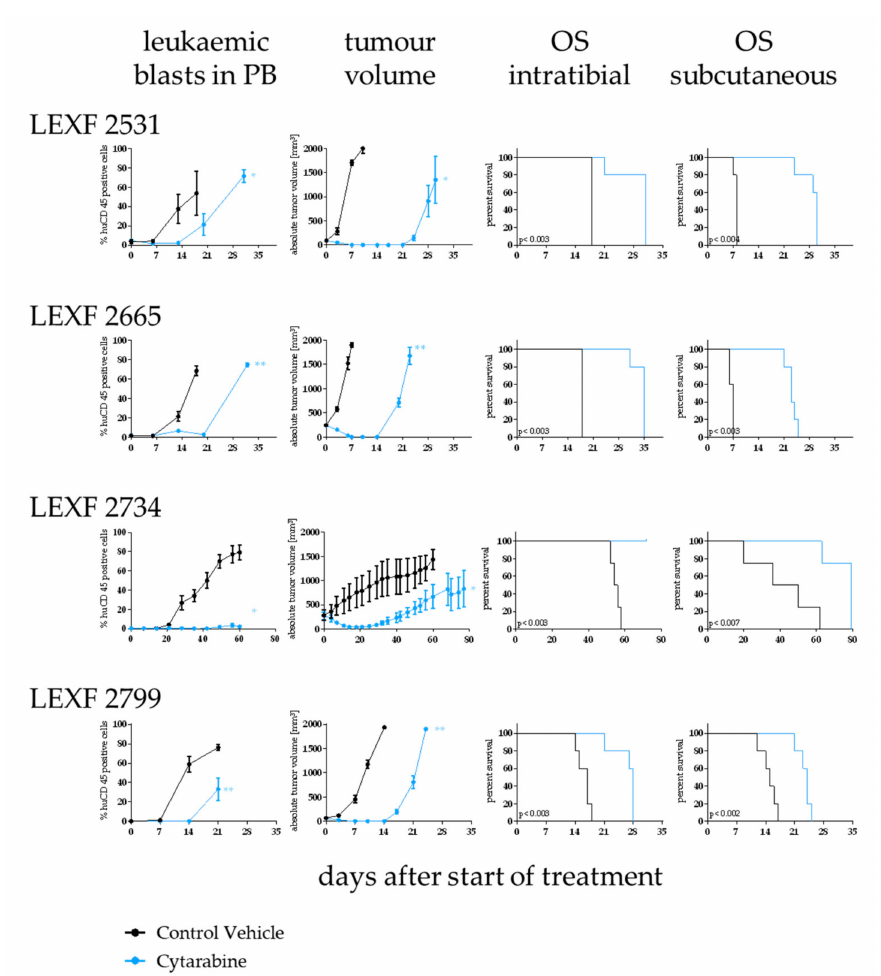
Figure 6. Determination of sensitivity towards cytarabine in four leukaemia PDX models depending on the implantation route of the tumour cells. Antitumor activity was determined by percentage of leukaemic blasts in peripheral blood (i.t. injected animals), tumour volume (s.c. implanted animals) and overall survival (i.t. and s.c.). Cytarabine was active an all tested models and settings although with varying degree depending on the model and the implantation site. Significance was calculated using the Log-rank (Mantel–Cox) test for OS and Mann–Whitney for tumour volume and percentage of human CD45 +